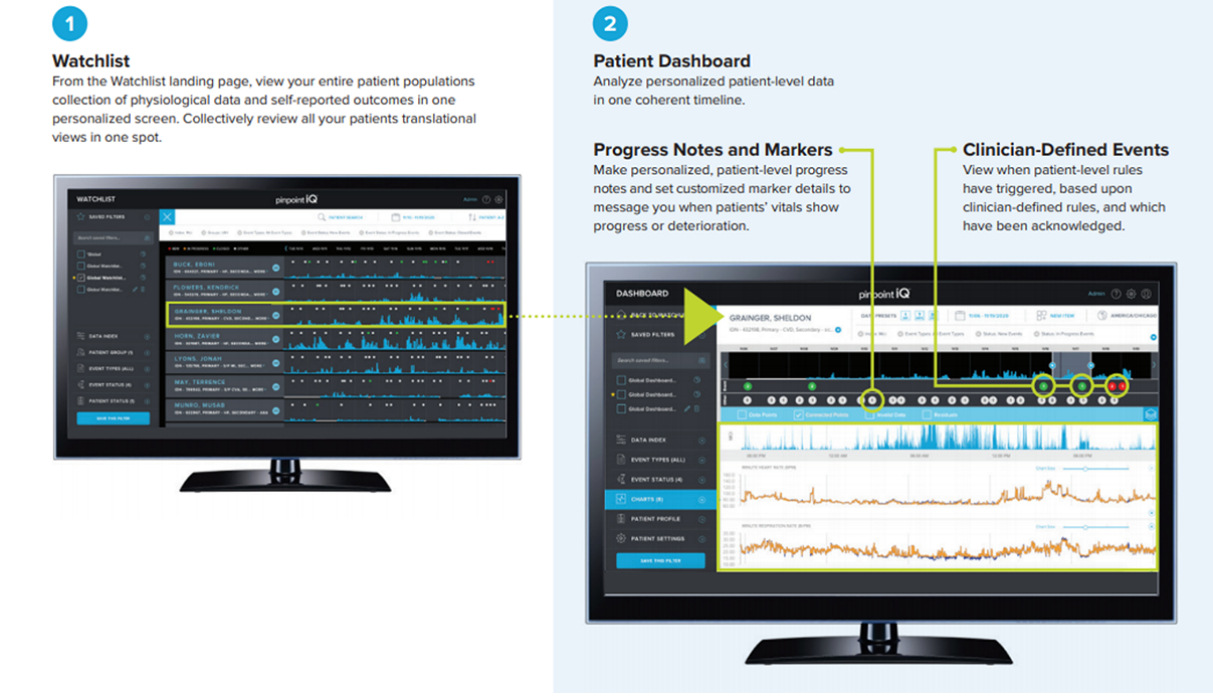
Figure 4. Watchlist and patient